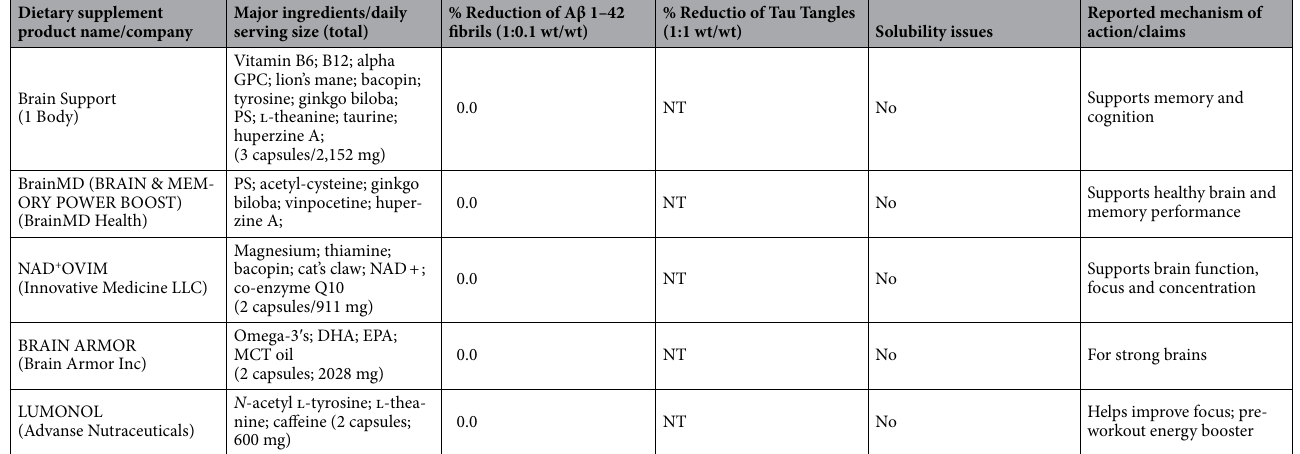
Table 1. Comparison of 21 memory-support supplements for reduction of Aβ 1–42 fibril and/or tau tangles. Major ingredients and reported mechanism of action/claims are also compared for each product